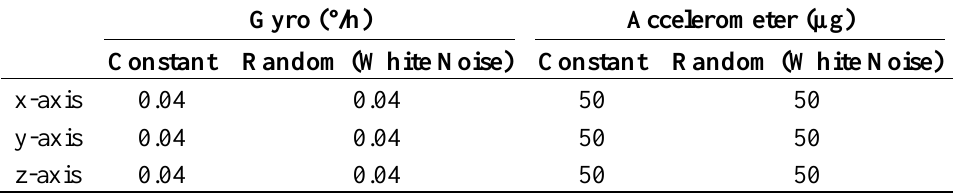
Table 5. Sensor errors.